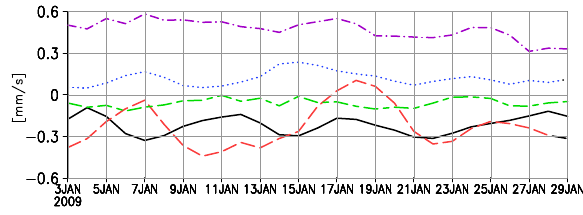
Fig. 6. Time series of residual mean vertical wind (mms − 1 ) in the tropics averaged over 150–100hPa, based on each component of forcings in the northern hemispheric troposphere. Meridional diver- gence of second meridional component of the EP flux F (φ) (black 2 solid line), vertical divergence of first vertical component of the EP flux F (z) (red dashed line), vertical divergence of second vertical 1 component of the EP flux F (z) (blue dotted line), eastward residual 2 forcing ¯ X (green long-short dashed line), and diabatic heating ¯ Q (purple dash-dotted line). Estimated vertical wind by other forcings is not shown because of its small value. See Table 1 for details.